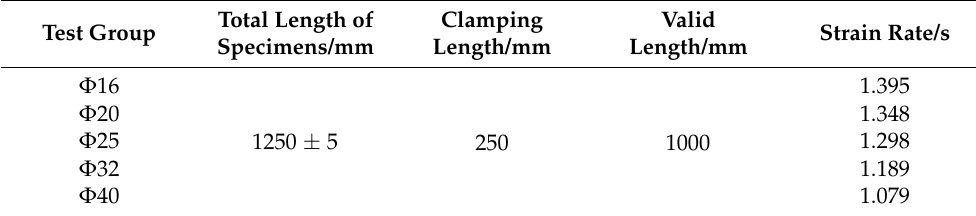
Table 3. Test design